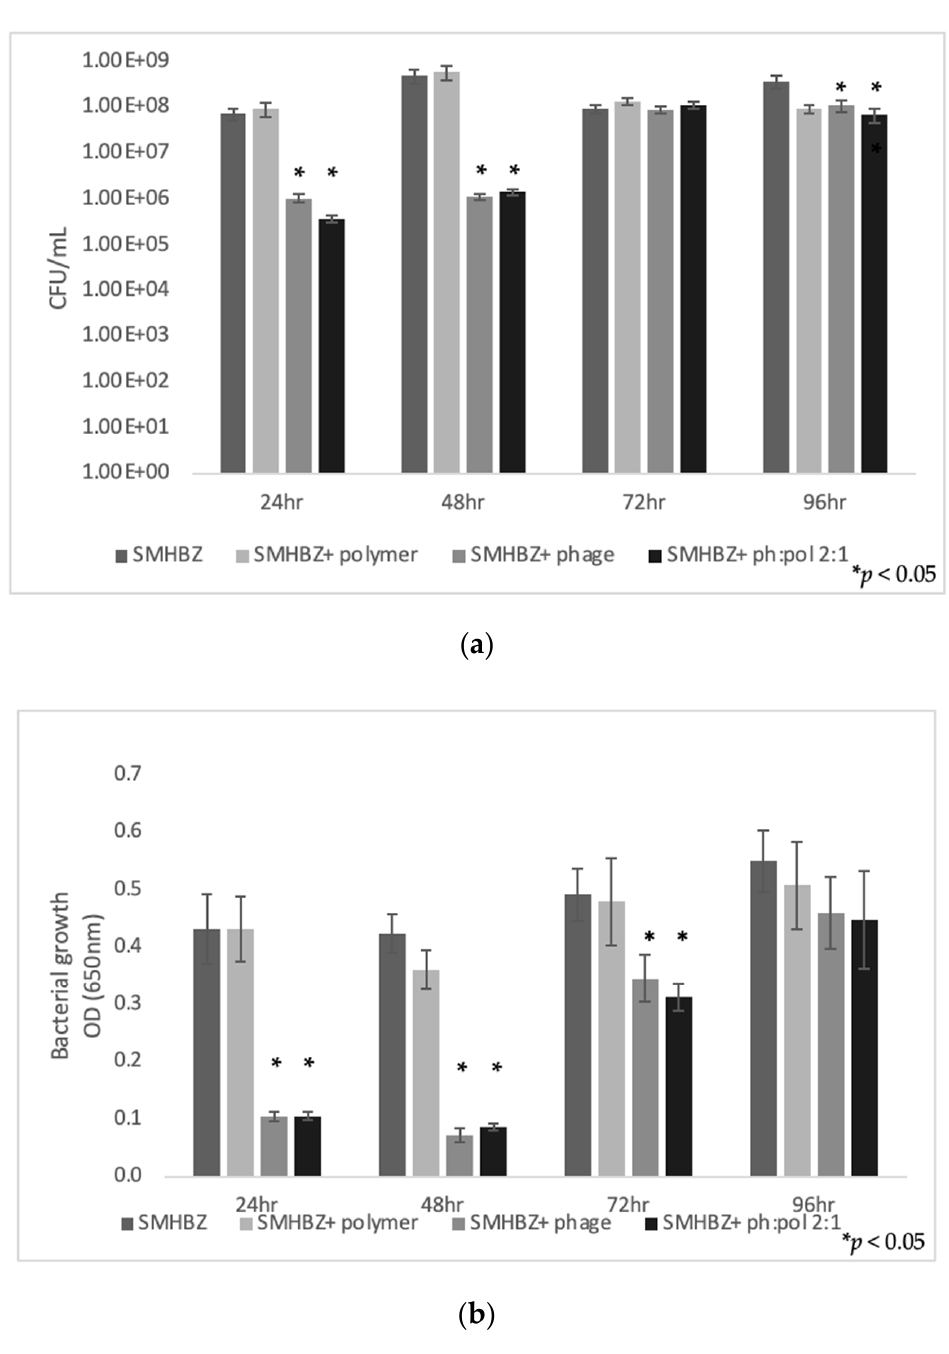
Figure 1. Treatment with phages and a polymer–phage formulation reduced bacterial growth of SMHBZ for 48 and 72 h compared with control groups (untreated bacteria and polymer alone), as depicted by ( a ) viable counts and ( b ) OD changes. Results are shown as mean ± SD based on five independent biological replicates.